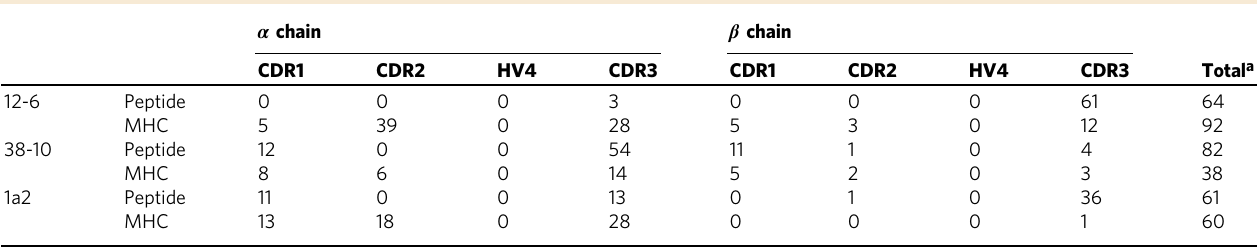
Table 2 TCR CDR atomic contacts with peptide and MHC (number of